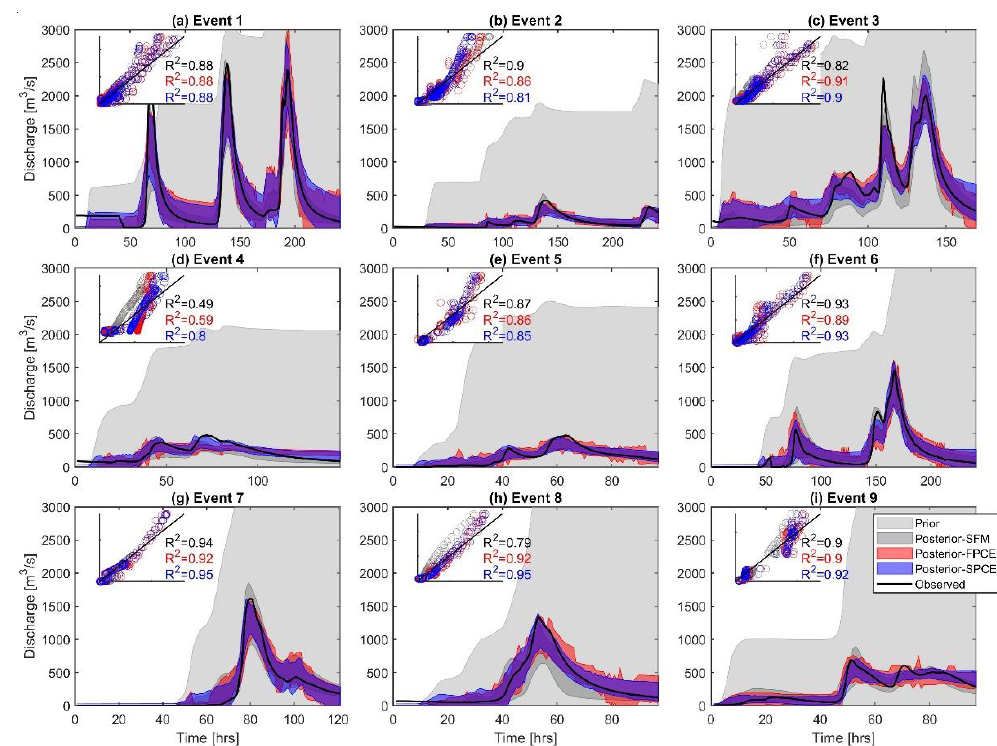
Figure 5. Streamflow predicted by SFM, FPCE, and SPCE for nine streamflow events. The 90% confidence bands are drawn using 1000 ensemble posterior members identified through GLUE. The scatter plots (and R2 values) represent 1:1 comparisons between the ensemble mean predictions (y-axis) and the observations (x-axis).